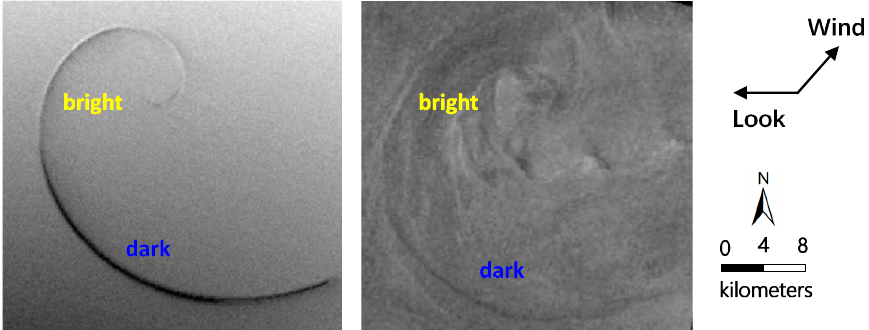
Figure 10. Comparison of ( a ) the simulated SAR eddy image and ( b ) the ERS-2 SAR image under the same radar parameters and wind field conditions. The radar look and wind direction are indicated by black arrows.